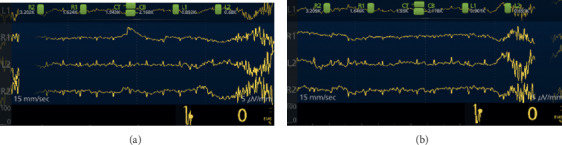
Four lead raw EEG from SedLine® displaying classic 1 : 10 burst to suppression ratio seen in neuroprotection with propofol in two separate patients from this study.